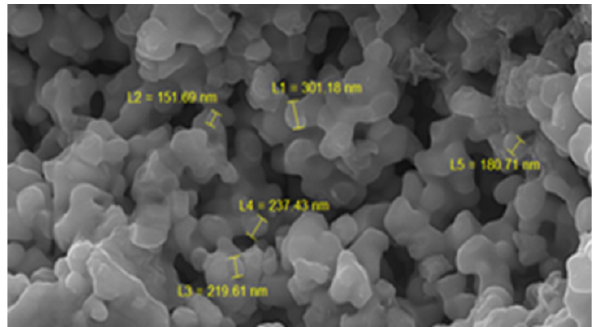
Figure 7: The nanostructured YSZ uniform distribution of porosities agglomerated nanostructured